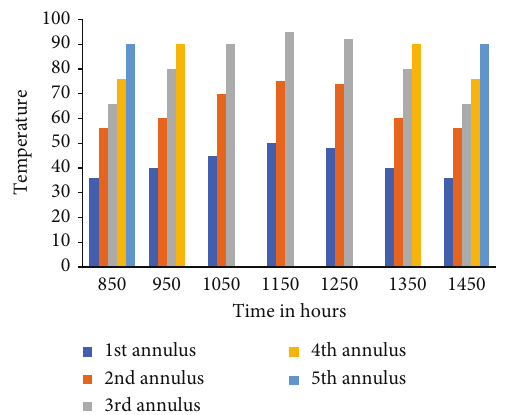
Figure 12: Need for evacuated tube collector in March 2021.